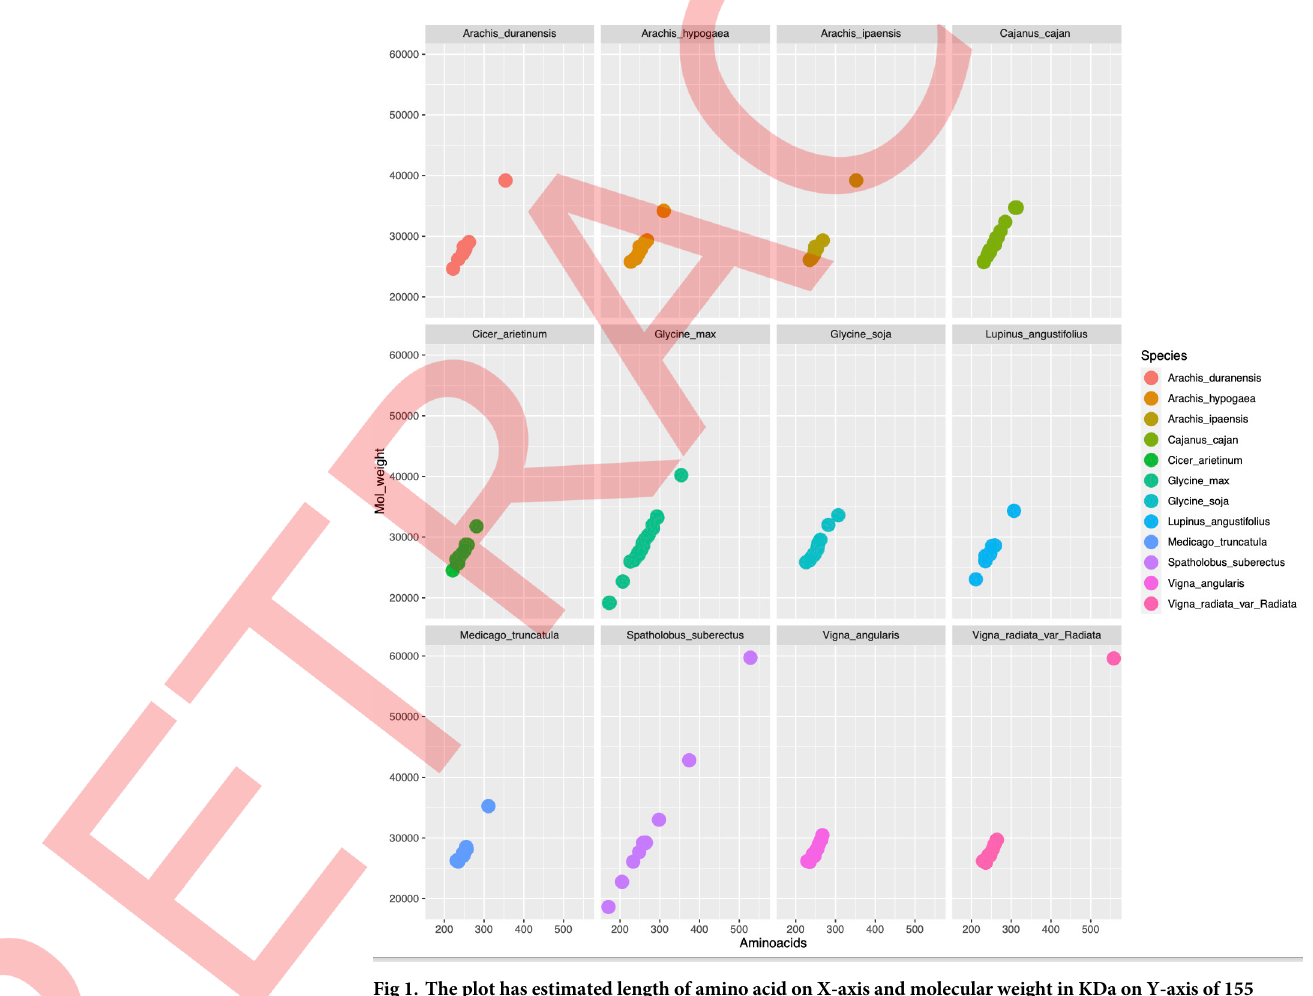
Fig 1. The plot has estimated length of amino acid on X-axis and molecular weight in KDa on Y-axis of 155 SWEET protein. The length of amino acid ranges from 171 to 558 while molecular weight lies between ~18.61 KDa to ~59.71